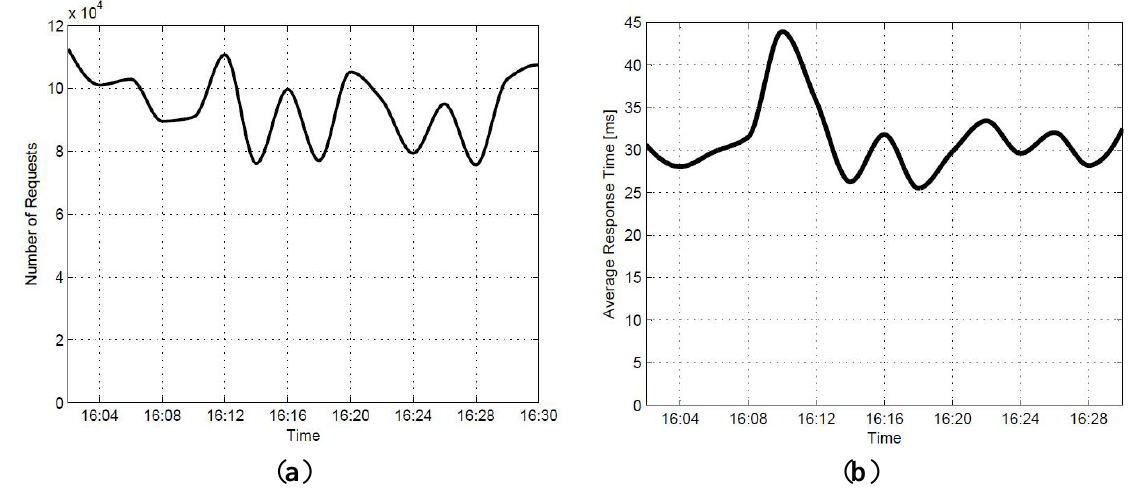
Figure 21. ( a ) The number of requests as a function of time; ( b ) The system’s average response